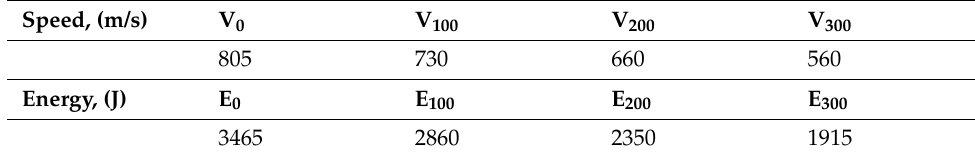
Table 1. Bullet 308 WIN